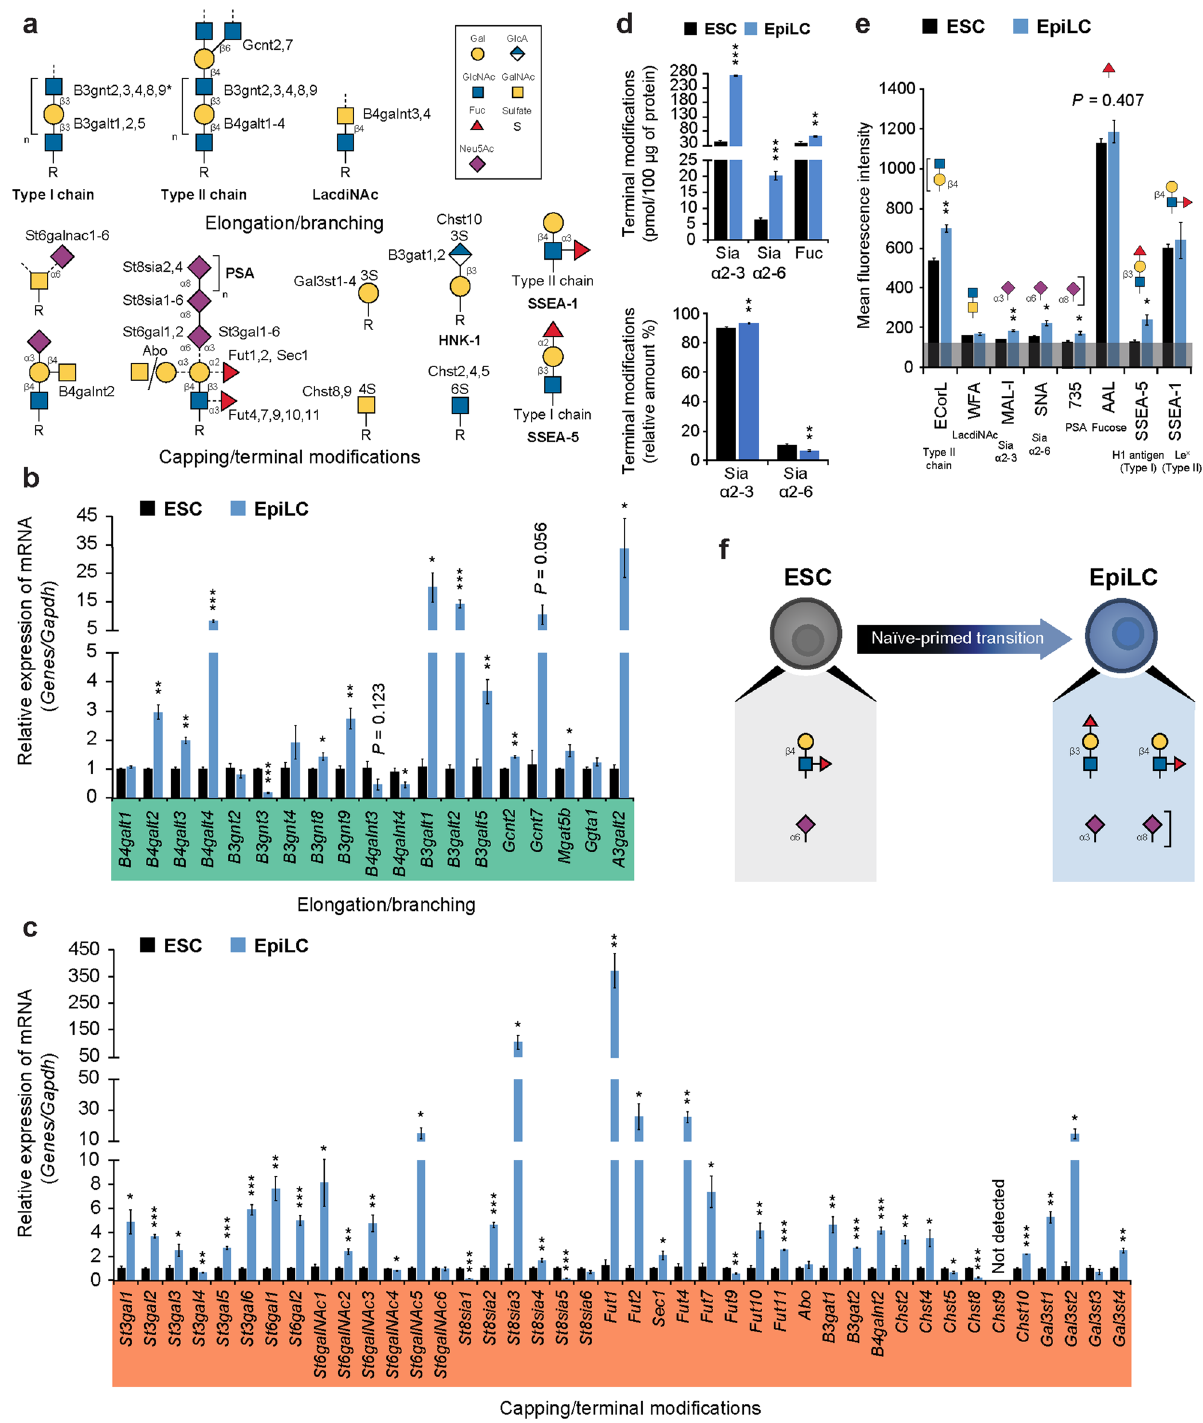
Figure 6. Pathway-non-specific structural and transcriptional analysis in ESCs and EpiLCs. ( a ) Schematic diagram of major pathway-non-specific structures. The asterisk denotes enzyme putative activity. ( b ) Real-time PCR analysis of elongation/branching enzymes normalized against Gapdh in ESCs and EpiLCs, and shown as a fold change relative to ESCs. ( c ) Real-time PCR analysis of capping/terminal modification enzymes normalized against Gapdh in ESCs and EpiLCs, and shown as a fold change relative to ESCs. ( d ) Total absolute amount of terminal modifications detected by MS in ESCs and EpiLCs (upper panel). Relative amount of total sialic acid in α2,3 and α2,6 configuration (lower panel). Fucose: Fuc; sialylation: Sia. ( e ) Pathway-non-specific structure profiling by FACS using specific lectins/Abs in ESCs and EpiLCs. Lectin/Ab specificities are stated below the labels and schematically represented above each histogram. The grey line at the bottom represents the negative control staining. ( f ) Model of pathway-non-specific alterations during ESC to EpiLC transition. Values are shown as means ± s.e.m. of three independent experiments in ( b , c , e ) and four independent experiments in ( d ). Significant values are indicated as * P < 0.05, ** P < 0.01, and *** P <